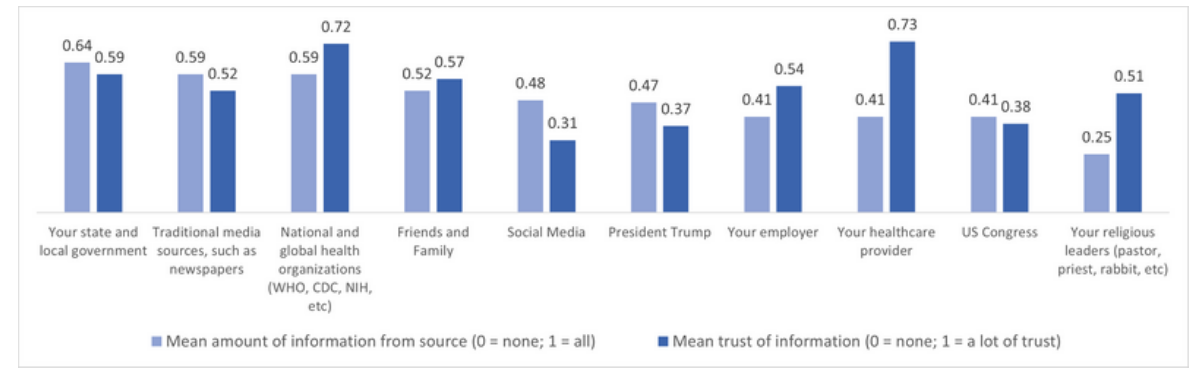
Figure 1 . Mean values of how much information, guidance, and opinions respondents reported hearing from different sources, and how much trust respondents reported having in various sources. Values have been normalized to a 0–1 scale. Mean values are representative of the U.S.